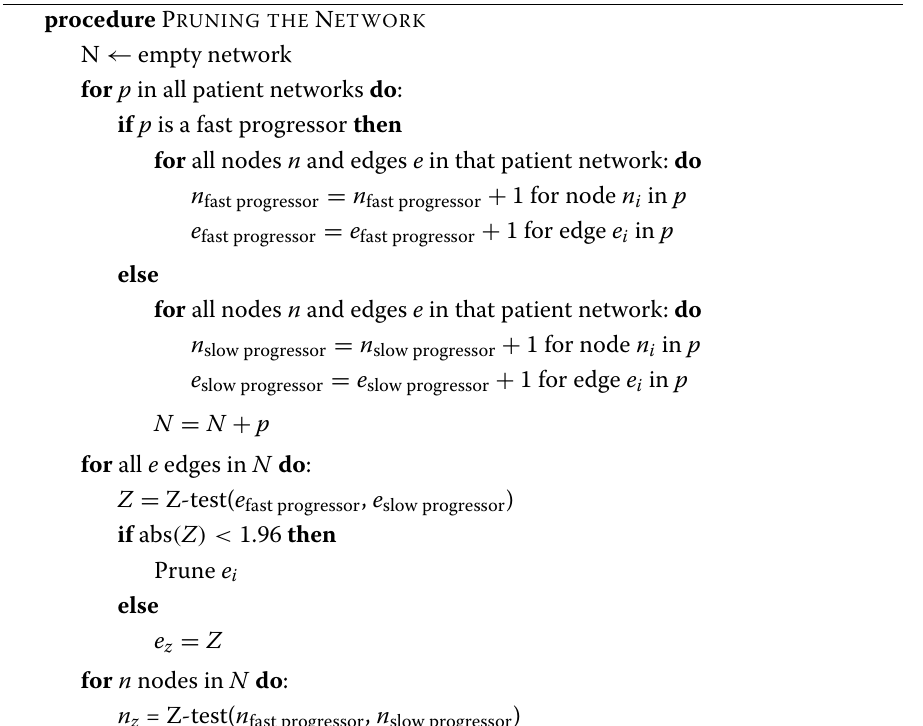
Algorithm 2 After the network is generated, we test to see which edges pass the two- sized Z-test by comparing how many patients are fast and slow progressors on each